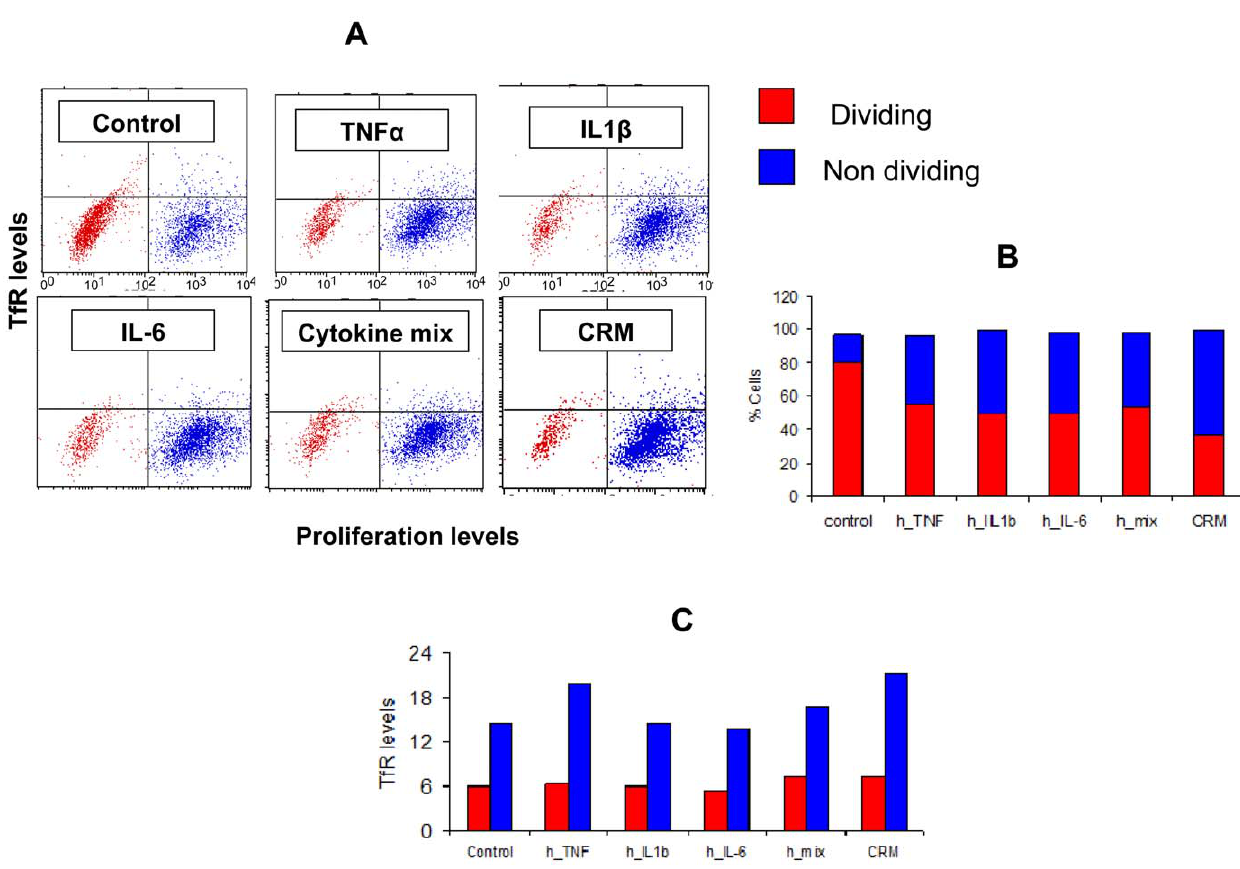
Figure 7. Increased TfR expression in CaCo-2 cells is not due to enhanced proliferation. Flow cytometry analysis of CaCo-2 cells double stained for CFSE dilution assay and TfR (mouse anti-human TfR stain), after incubation with the following inflammation mediators: TNF a , IL1 b , IL-6, a mixture of the three, or CRM from mouse source. (A) Dot plot of stained TfR levels and the proliferation marker, CFSE. Dividing cells are marked in red, non-dividing cells are marked in blue; (B) Quantification of the dot plot shown in A; (C) TfR quantification in the dividing (red) and non-dividing (blue)